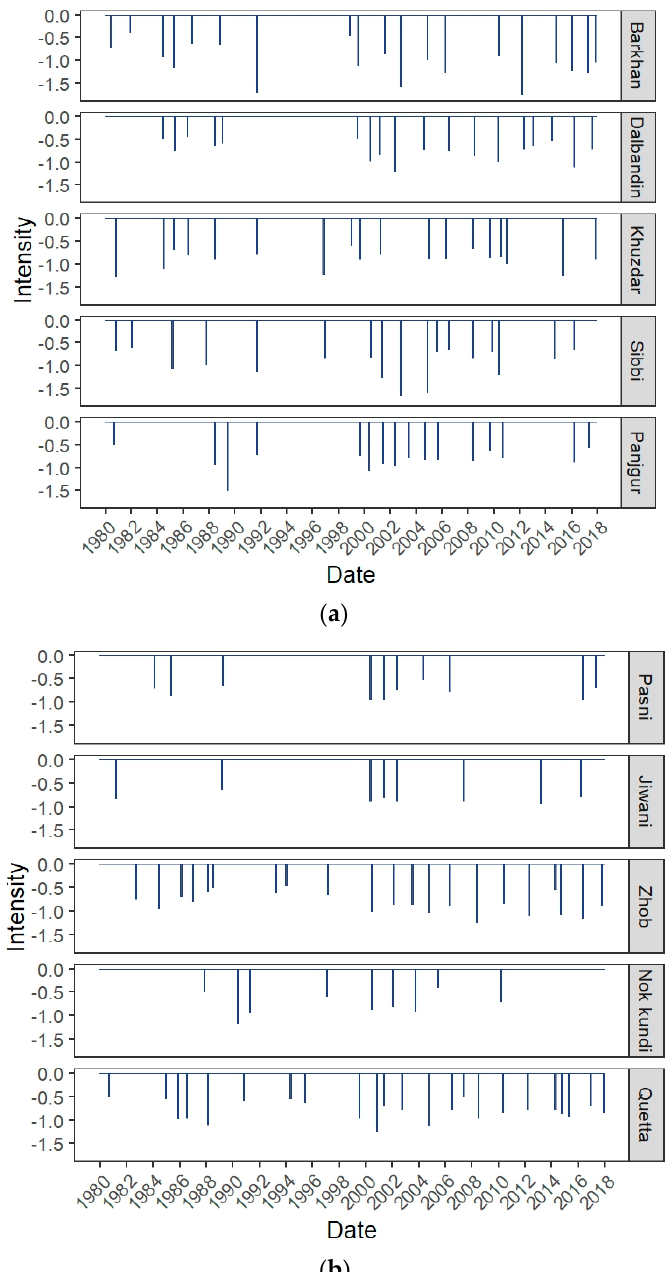
Figure 13. Drought severity at all stations.